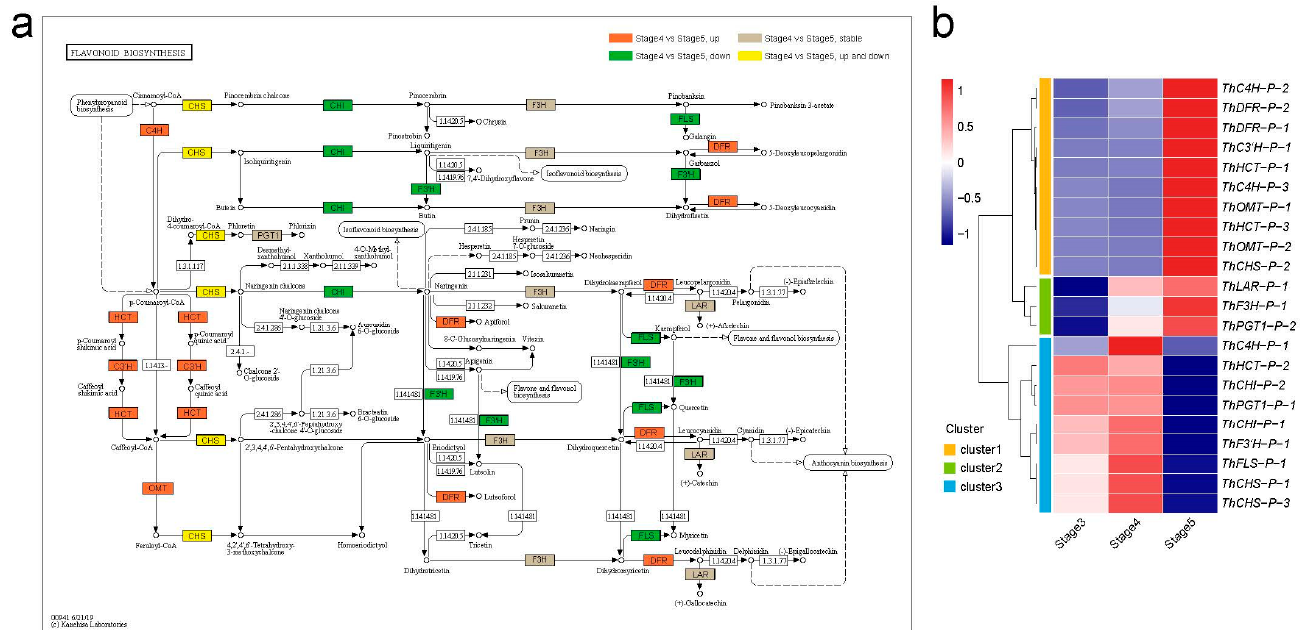
Figure 4. Analysis of DAPs in the flavonoid biosynthesis pathway. ( a ) Mapping of enriched DAPs in the flavonoid biosynthesis pathway (ko00941) [44–46]. The orange marks represent DAP upregulated in stage 5 vs. stage 4; the green marks represent DAPs downregulated in stage 5 vs. stage 4; the yellow marks represent the upregulated DAPs and downregulated DAPs in stage 5 vs. stage 4. The grey marks represent proteins stable in stage 5 and stage 4. ( b ) Abundance pattern of DAPs involved in flavonoid biosynthesis pathway at different stages.